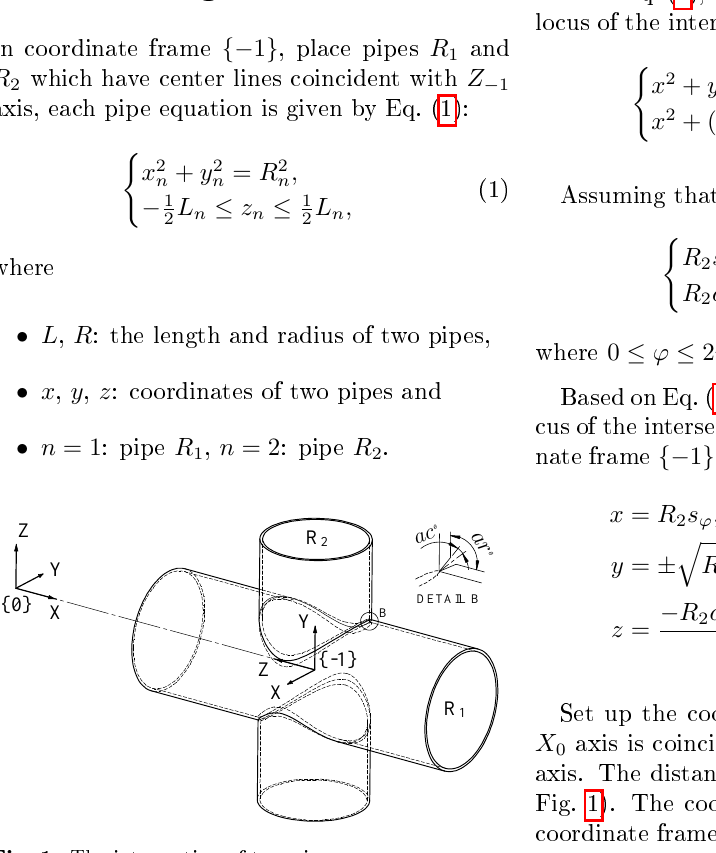
Fig. 1: The intersection of two